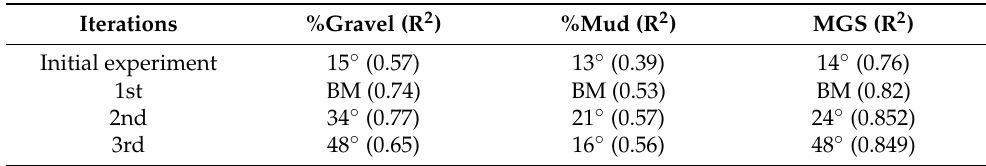
Table 4. Selected feature variables for predicting the sediment properties and the proportion of variance explained by the model (R 2 ) when BM and BS were set as explanatory variable.